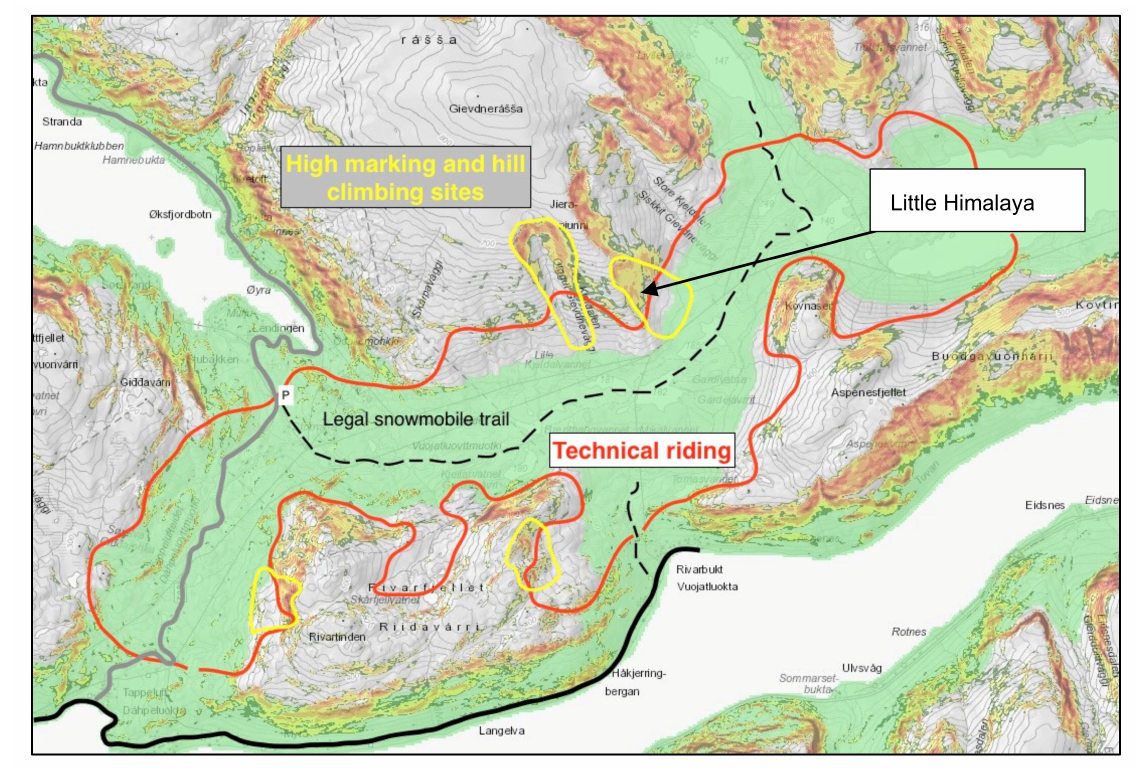
Figure 4. Focus area 1b. Yellow polygons show areas that used to be popular for high-marking and hill climbing. Red polygon shows the area which is now used for technical riding. The polygons are overlaid on a map from www.senorge.no (accessed on 6 January 2022), showing terrain steeper than 30 degrees (yellow to red) and forest/vegetation